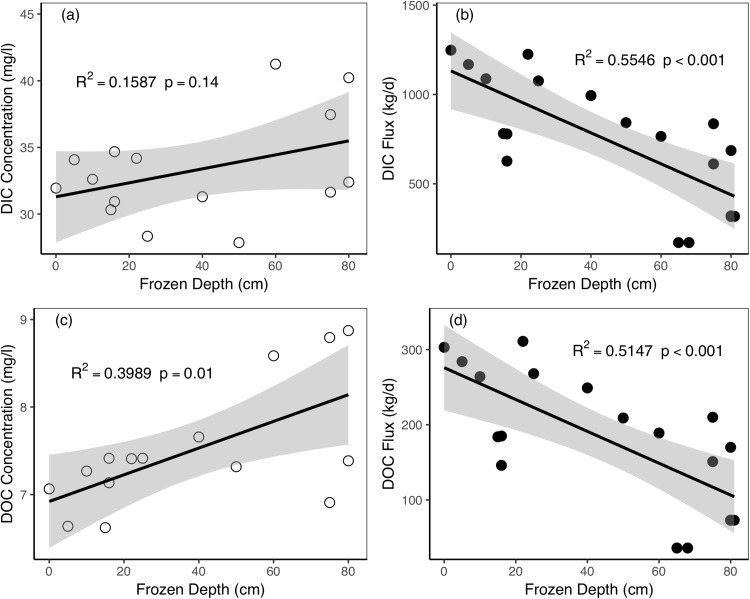
Relationships between active layer frozen depths and riverine dissolved carbon concentrations and fluxes during the freezing period in Catchment 3.(A) Frozen depth vs. DIC concentration; (B) frozen depth vs. DIC flux; (C) frozen depth vs. DOC concentration; (D) frozen depth vs. DOC flux. The shaded regions in the graphics are 95% confidence interval.